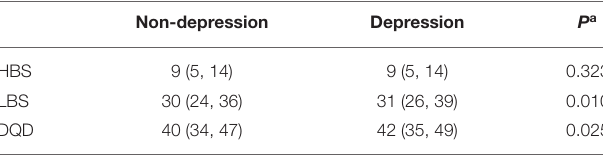
TABLE 4 | Poisson regression analysis of associations of diet quality and postpartum